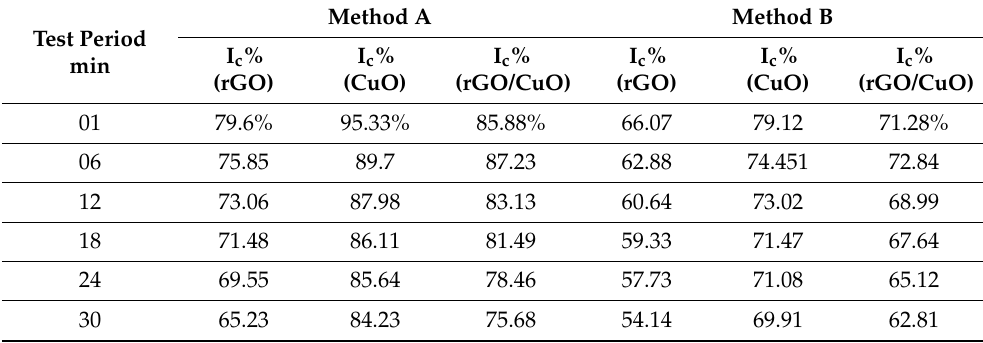
Figure 3. Effects of test temperature on the crystallinity index values of rGO, CuO, and 1.0 wt.% rGO/CuO, using methods A and B at 1.0 h. Table 3. Effect of temperature on I c % values of rGO, CuO, and 1.0 Wt.% rGO/CuO at 1 h. Table 4. Effect of test time on I c % values of rGO, CuO, and 1.0 wt.% rGO/CuO at 20 ◦